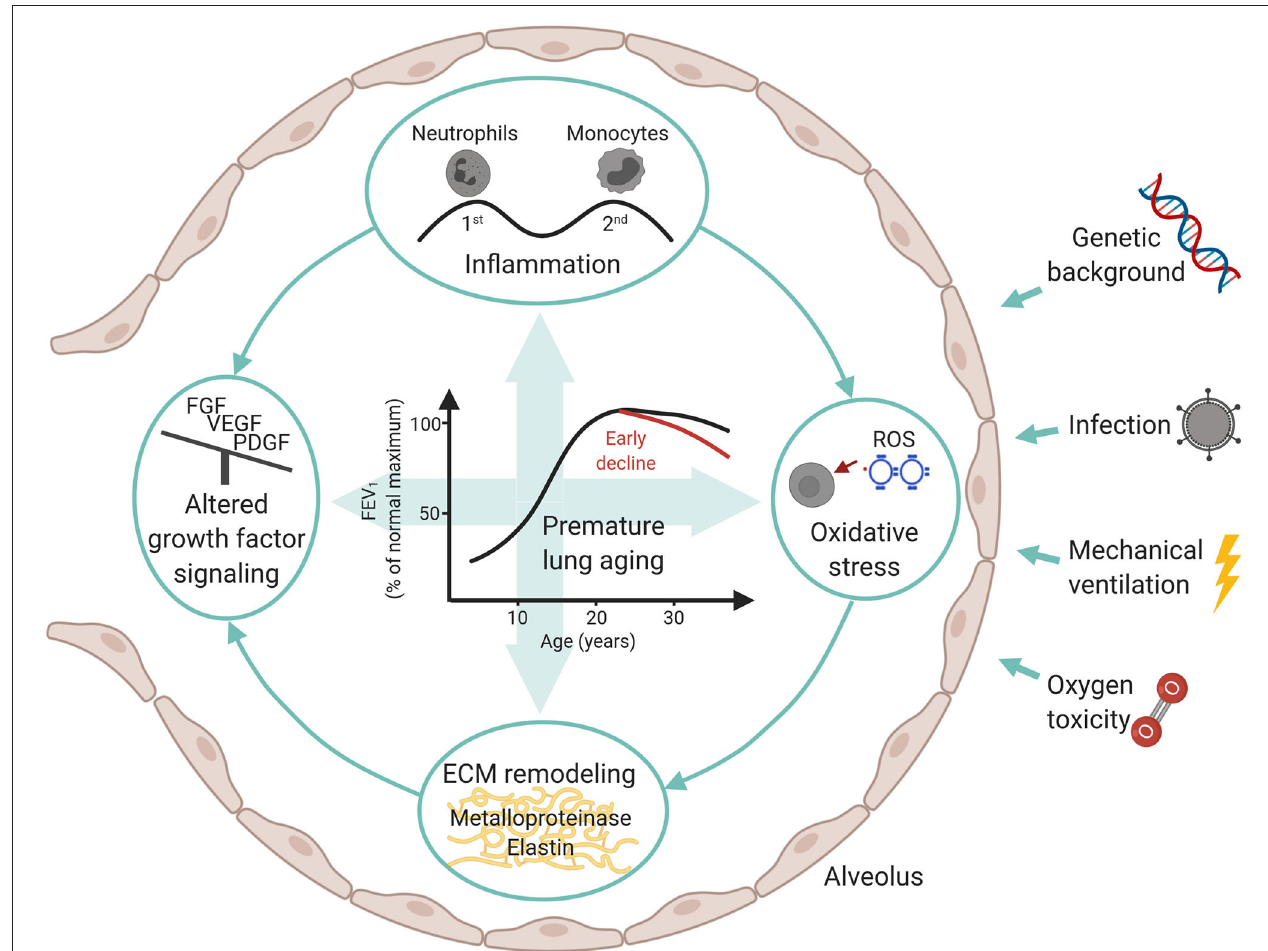
FIGURE 1 | Overview over influencing factors and molecular mechanisms in BPD development with a focus on long-term